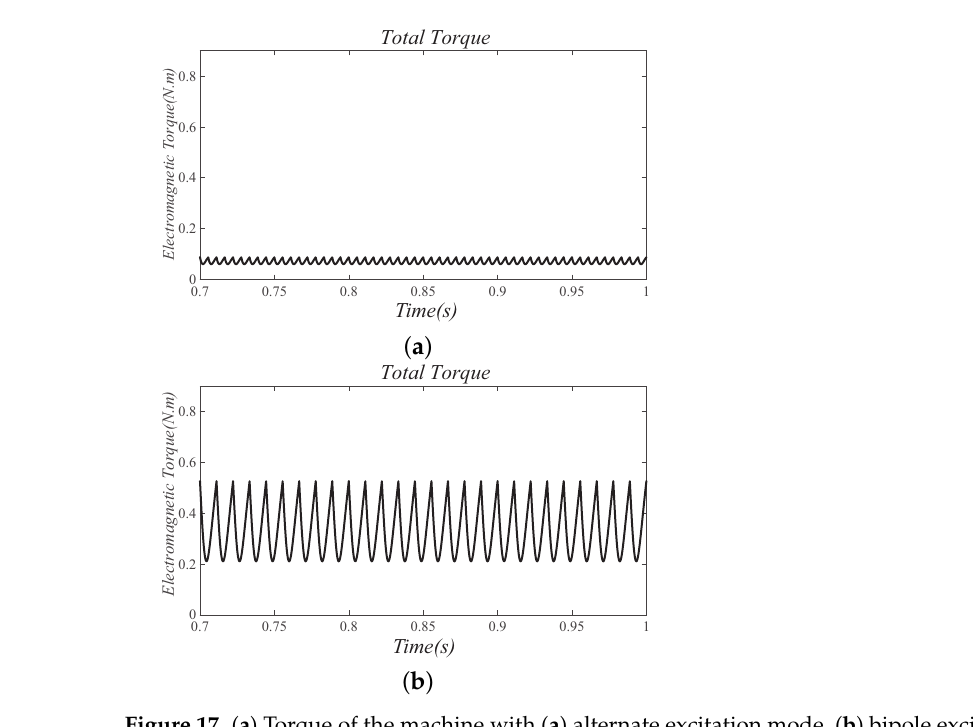
Figure 17. ( a ) Torque of the machine with ( a ) alternate excitation mode, ( b ) bipole excitation